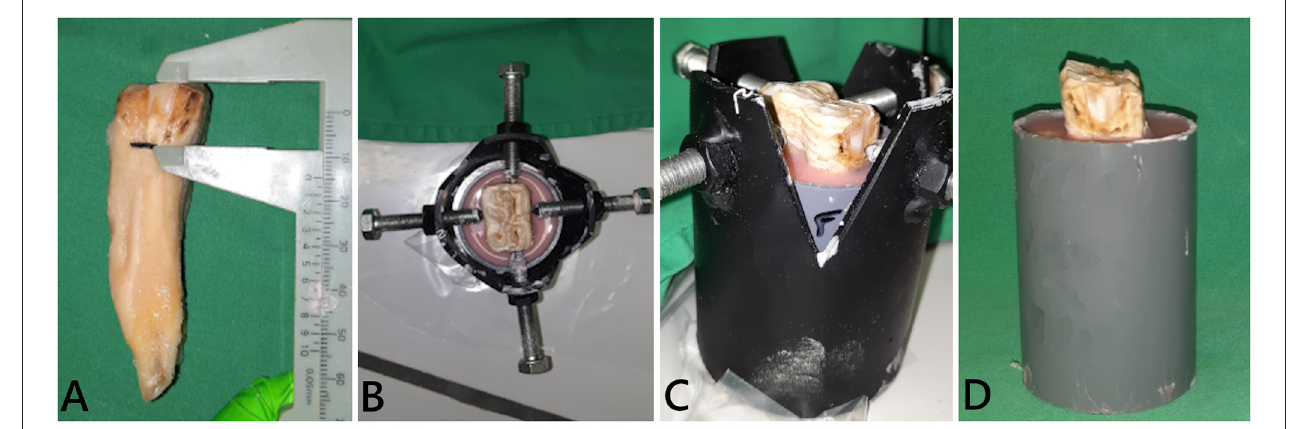
FIGURE 2 | Embedding of a tooth in resin blocks. (A) The simulated bone level was determined on a tooth stripped of periodontal ligament. The tooth was fixed in a custom-made holder at the desired height and position [ (B) dorsal view; (C) side view]. (D) Final tooth fixation.